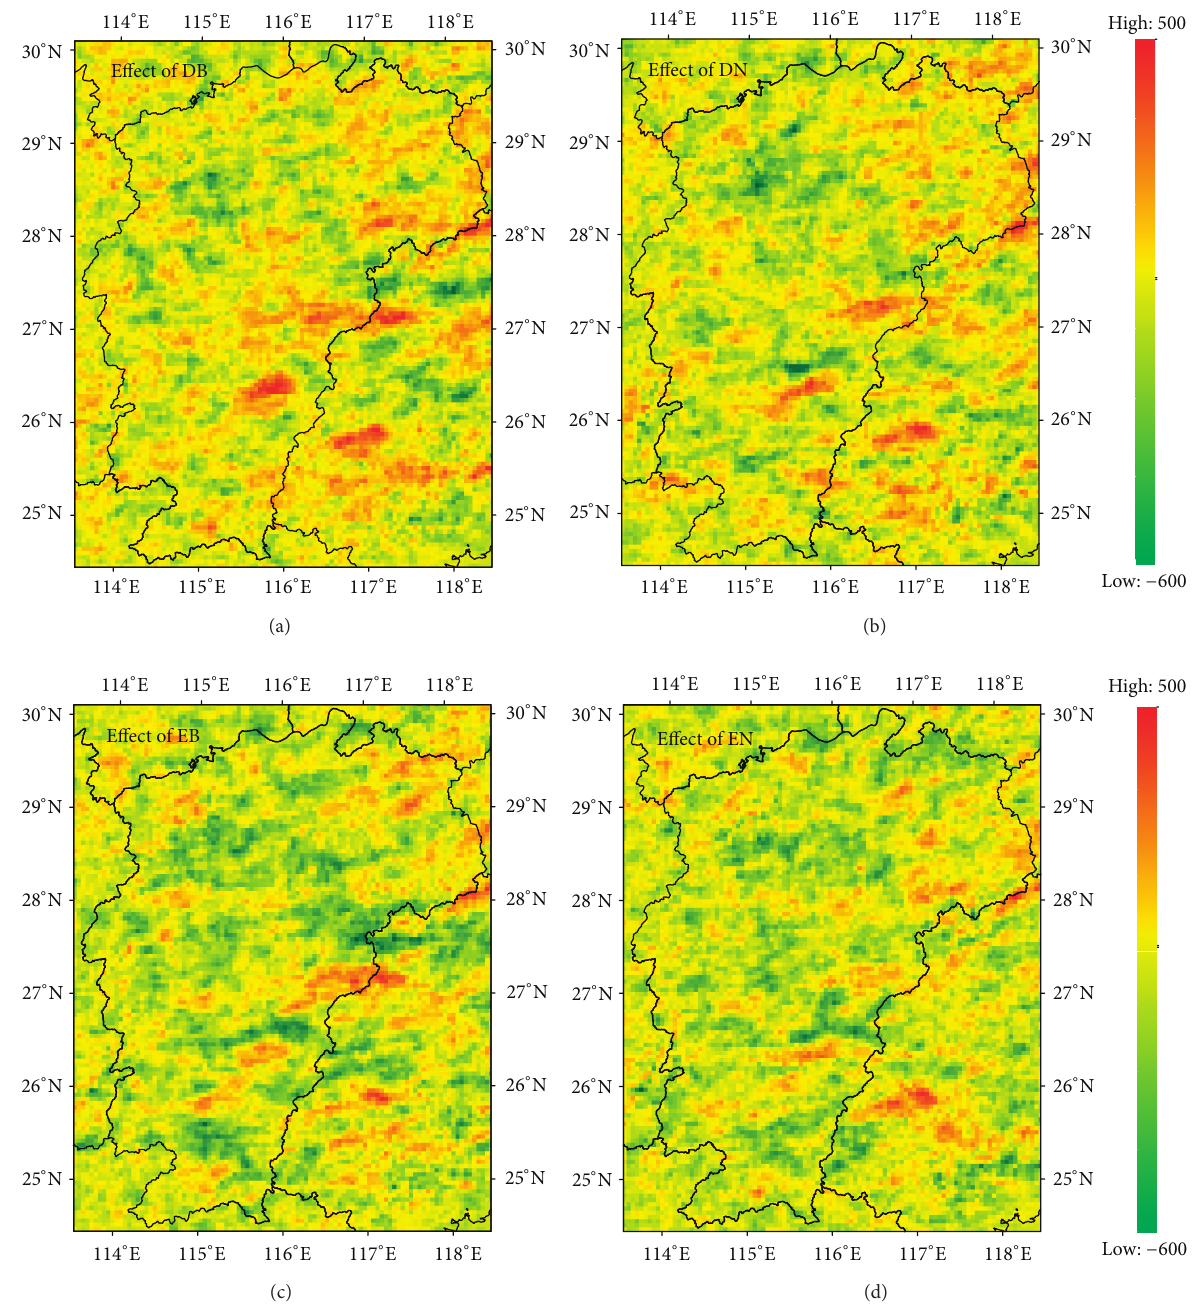
Figure 3: Simulated effects of afforestation on the annual average precipitation (measured in milimeters) in Jiangxi Province.